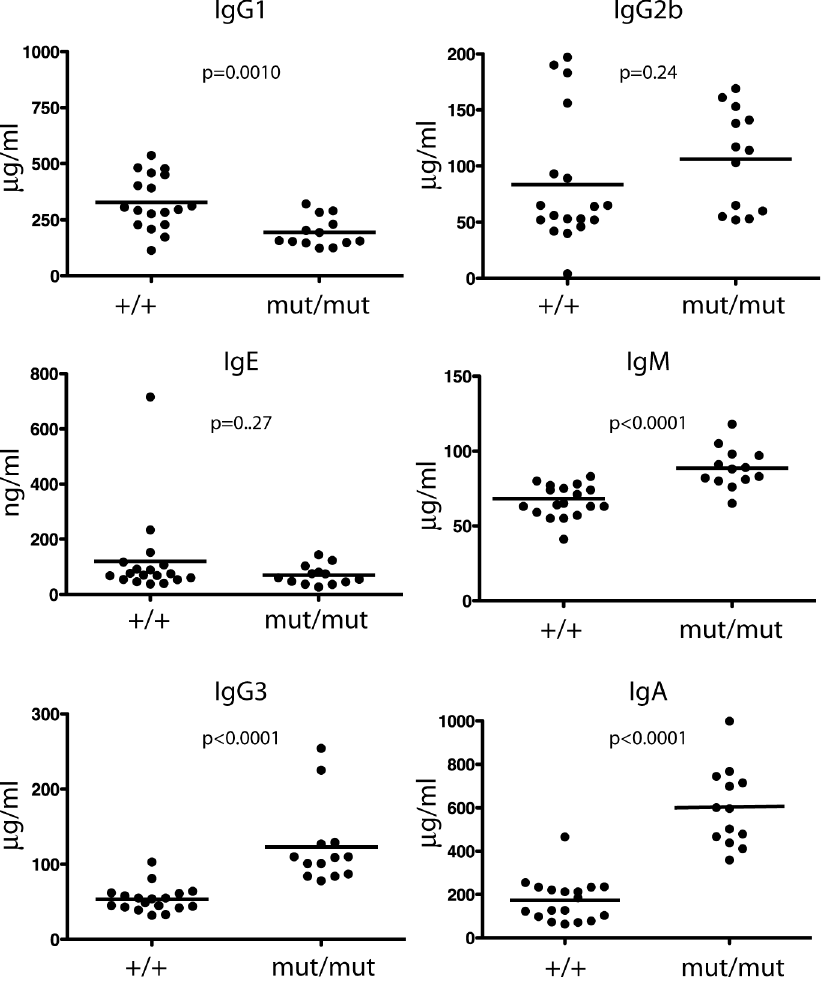
Figure 4. Serum immunoglobulin levels in c-IAP2 H570/H570A mice. Wild type ( + / + ) and c-IAP2 H570A/H570A (mut/mut) mice were 8–10-wk-old, each dot represents the titer for an individual mouse, and the horizontal lines indicate the mean titer for each